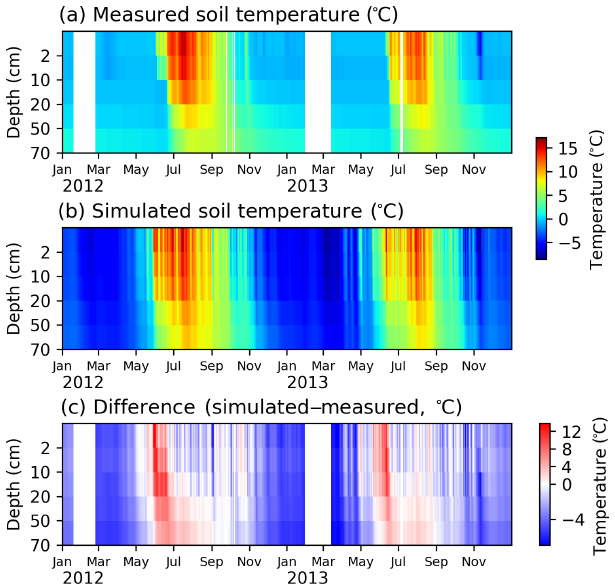
Figure 7. Measured (a) and simulated (b) soil temperature, and their differences (c) at the DK-NuF (64.13 ◦ N, 51.39 ◦ W) fen site. Soil temperature was measured at 2, 10, 20, 50, and 70cm below soil surface. To compare simulated soil temperatures with the mea- surements, we linearly interpolated simulated soil temperature in different layers to the depths of the measurements.